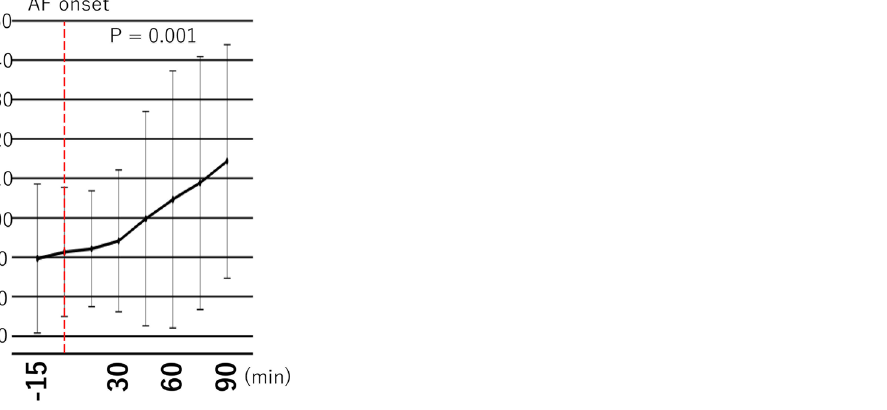
Figure 3. Interstitial glucose level immediately after the onset of early recurrence of atrial fibrillation